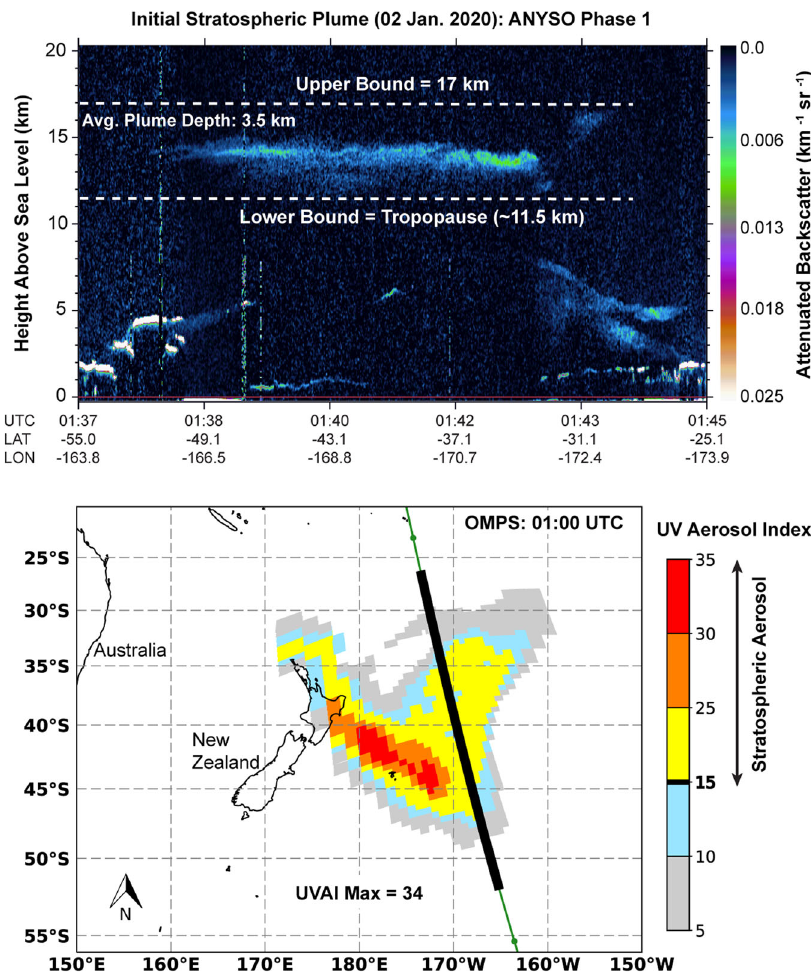
Fig. 7 Characteristics of the initial phase one stratospheric smoke plume. Top panel shows pro fi les of 532 nm attenuated backscatter (km − 1 sr − 1 ) observed by CALIOP on 02 January 2020 for a daytime (ascending) CALIPSO overpass beginning 01:37 UTC. Dashed white lines denote the approximate upper and lower bounds of the plume. Bottom panel shows near-coincident ultra-violet aerosol index (UVAI) observations from OMPS. The CALIPSO satellite track is superimposed green, with black indicating the segment used in the top panel. The horizontal extent of the stratospheric smoke plume (AI ≥ 15) is displayed in shades of yellow and